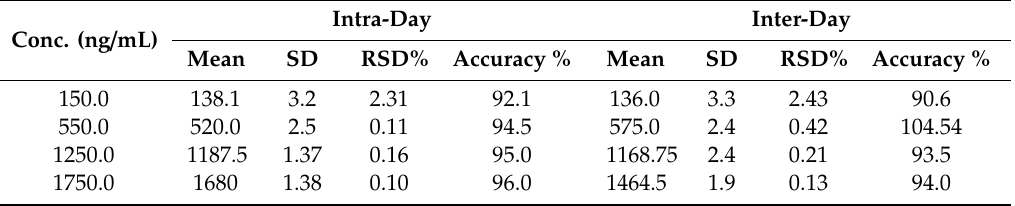
Table 5. Accuracy and precision of the quality control samples by the proposed HPLC. Conc. (ng / mL)